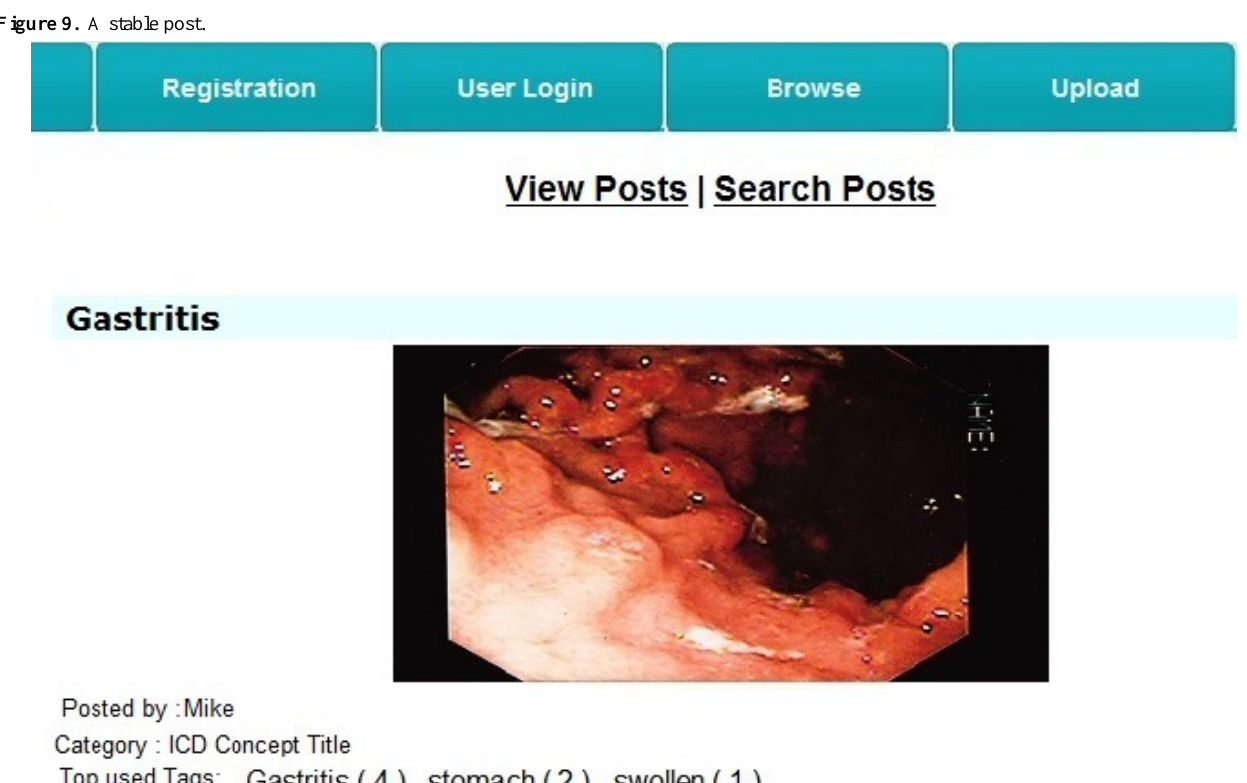
Figure 9. A stable